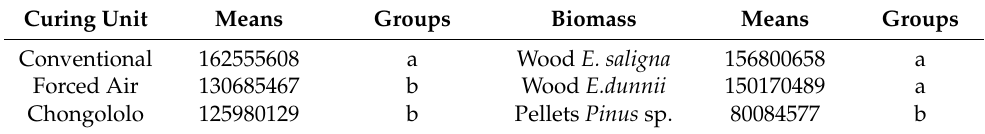
Table 4. Tukey test results at 95% probability.